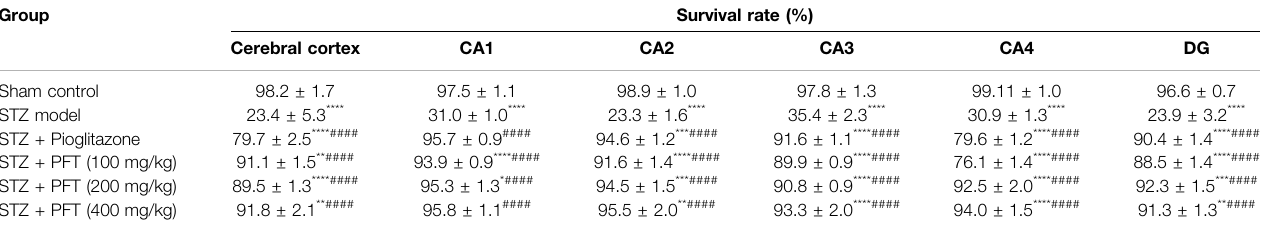
TABLE 2 | The percent of survival neurons of mice brain in the cerebral cortex and various area of the hippocampus that recorded in different experimental groups. Group Survival rate (%) Cerebral